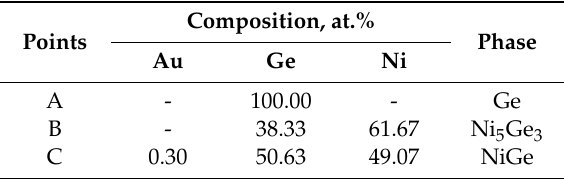
Figure 8. The SEM image of Cu / Ni / Au / Au-12Ge / Au / Ni / Cu interfacial layer: ( a ) 100 cycles; ( b ) 200 cycles; ( c ) 300 cycles; ( d ) 400 cycles. Table 3. The EDS results of Figure 8a.